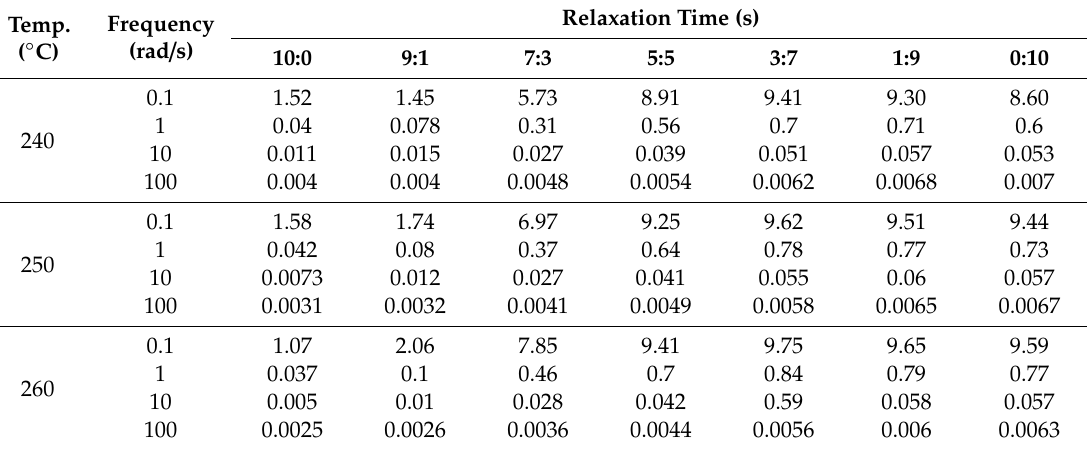
Table 2. Relaxation time of PC / ABS blends at various temperatures.